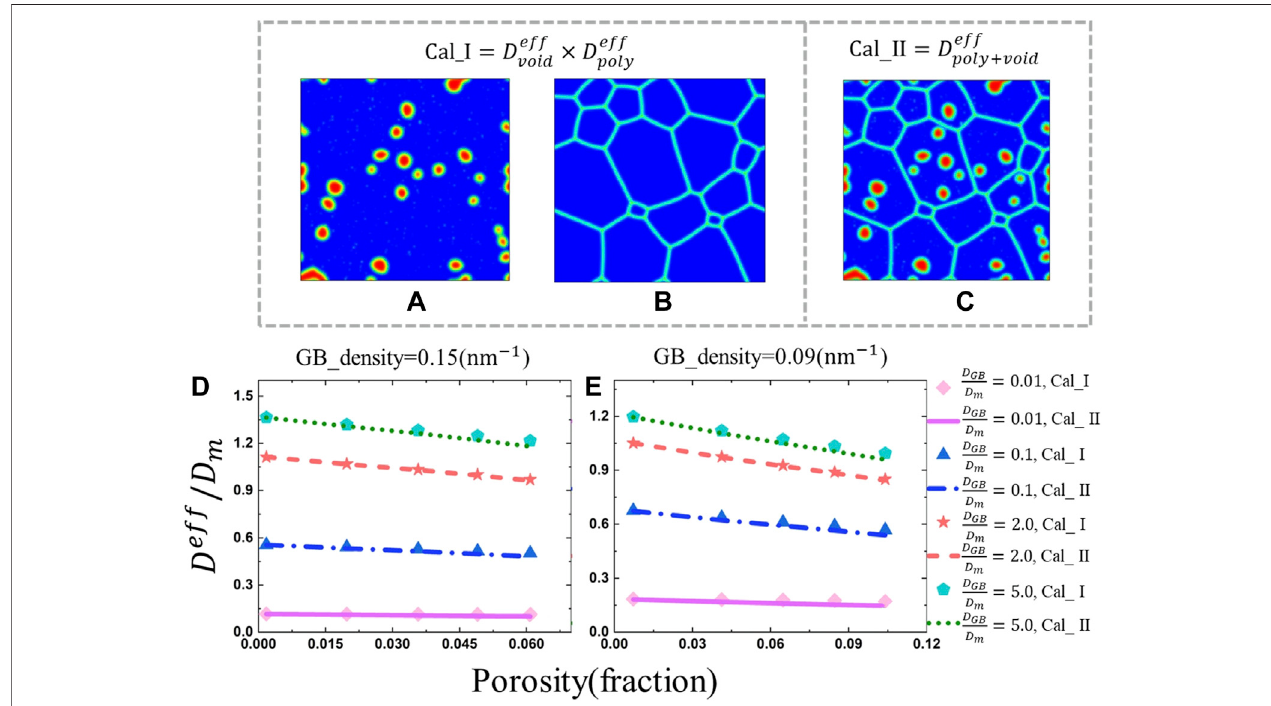
FIGURE7| Microstructureusedforthe fi rstmethod (A,B) andsecondmethod (C) forcalculatingtheeffectivediffusioncoef fi cient.Comparisonofthevalue D eff / D m calculated by two different methods as a function of the porosity under two different grain boundary densities of 0.15 nm − 1 (D) and 0.09 nm − 1 (E) , in which the scatter points denote D eff / D m obtained by the fi rst method, and the curves represent that obtained by the second method.